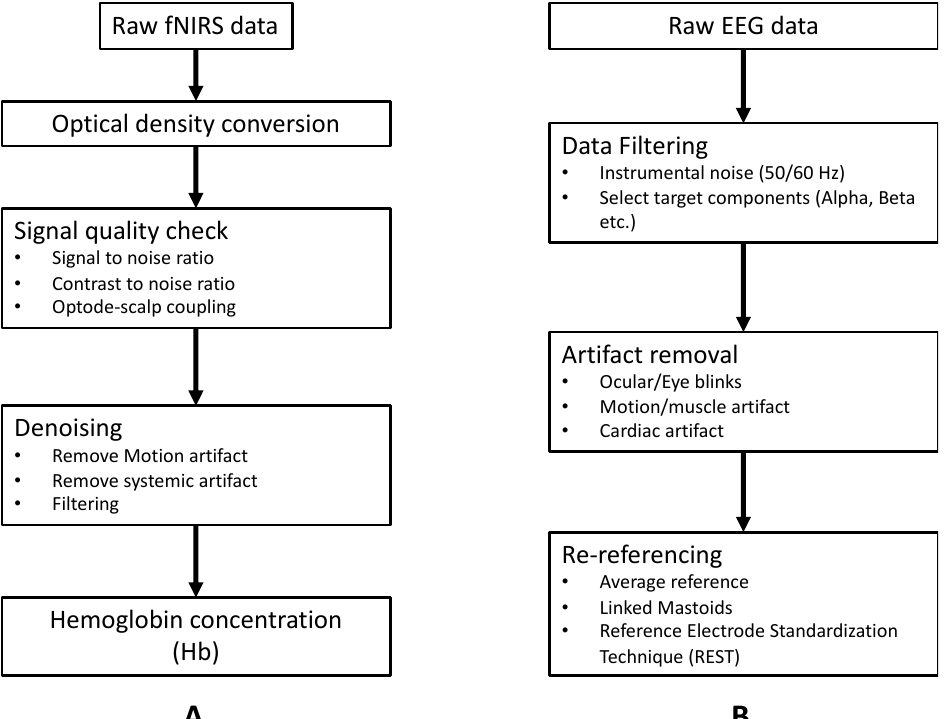
Figure 5. Basic preprocessing pipeline: ( A ) fNIRS raw data and ( B ) EEG raw data.